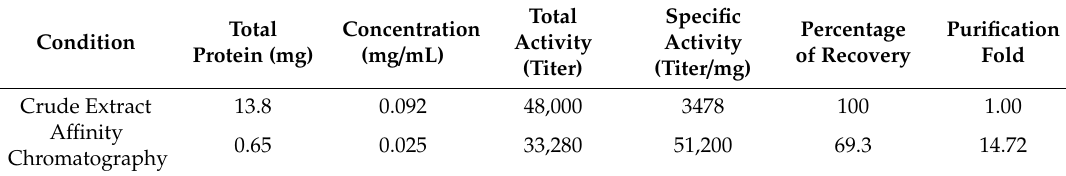
Figure 1. Purification of Grateloupia chianggi lectin (GCL) using D-mannose affinity chromatography. M = molecular weight marker; 1 = crude extract lane; 2 = flow-through fraction lane; 3 = purified GCL lane. Table 2. Purification of Grateloupia chianggi lectin (GCL) from 30 g of G. chiangii. Hemagglutination activity was determined using horse erythrocytes.